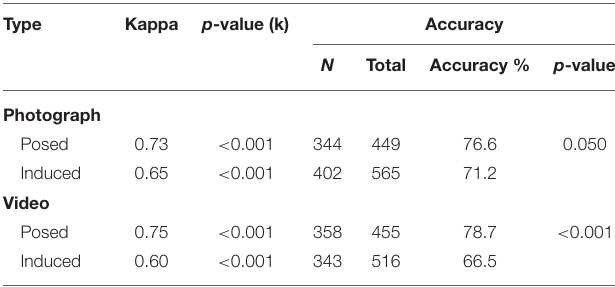
TABLE 3 | Agreement between judges 3 and 4 regarding facial expressions of different emotions according to induction method (posed or